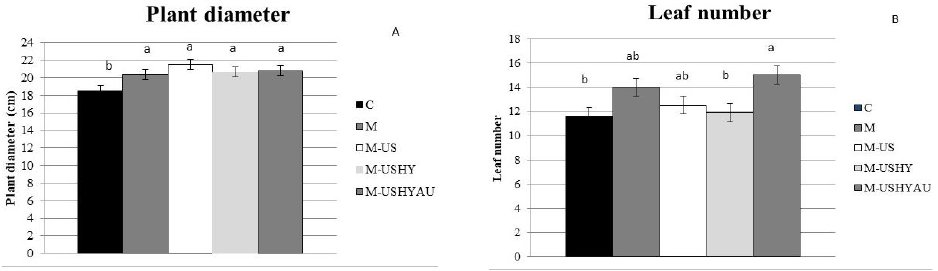
Figure 1. Stem diameter (cm) ( A ) and shoot number ( B ). Data are means ± standard error. Values followed by different letters are significantly different ( p ˂ 0.05). The values are the means of data from 12 plants for each replicate.